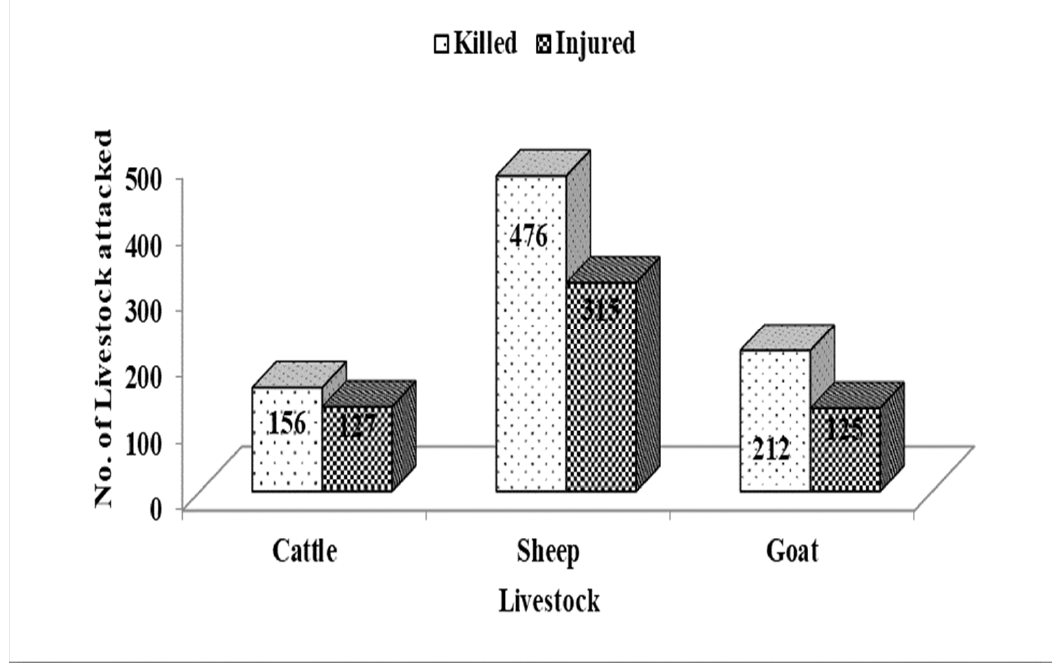
Figure 3. Number of livestock killed or injured in livestock depredation incidences.